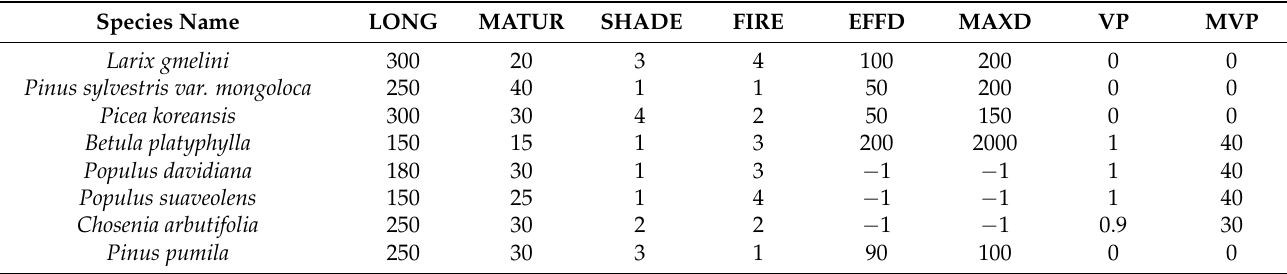
Table 2. Species’ vital attributes for the study